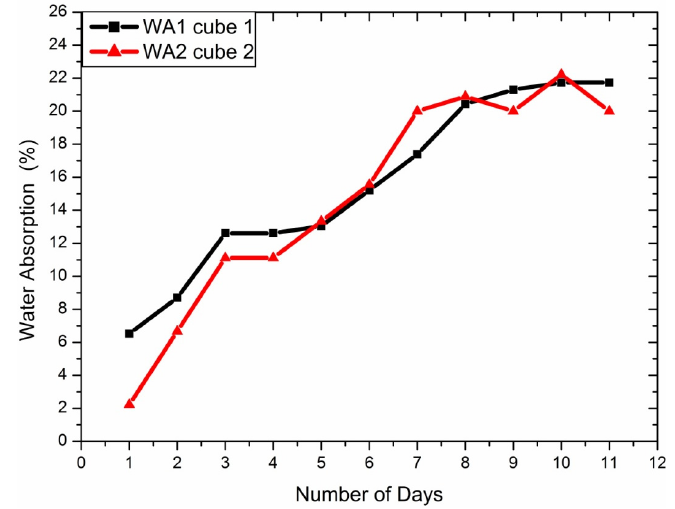
Figure 5. Water absorption percentage based on the number of days.